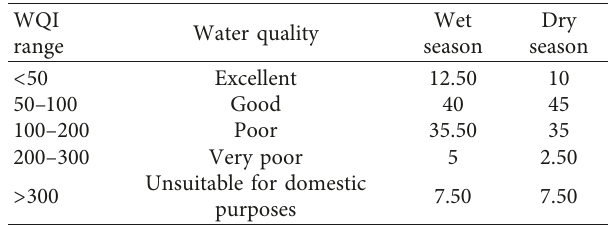
− (a) NH 4+ (b) and NO − (c). 2 versus NO 3 2 Table 4: Water Quality Index (WQI) ranges and percentage of samples during wet and dry